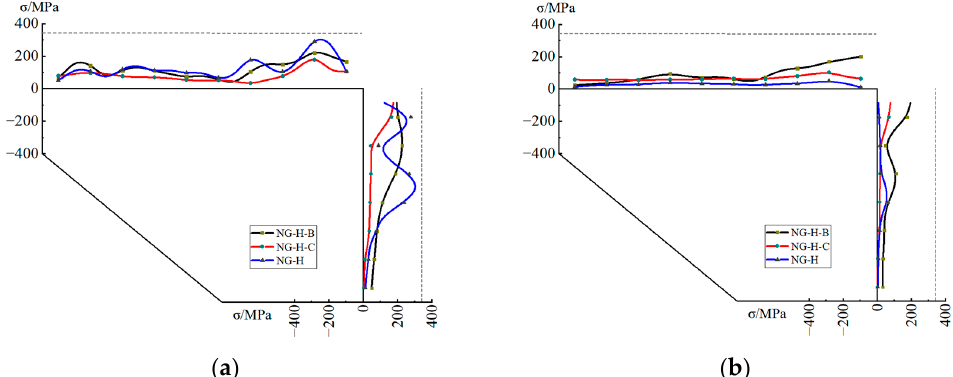
Figure 18. Comparison of displacement contours in specimens NG-H, NG-H-B and NG-H-C: ( a ) vertical; ( b ) horizontal.